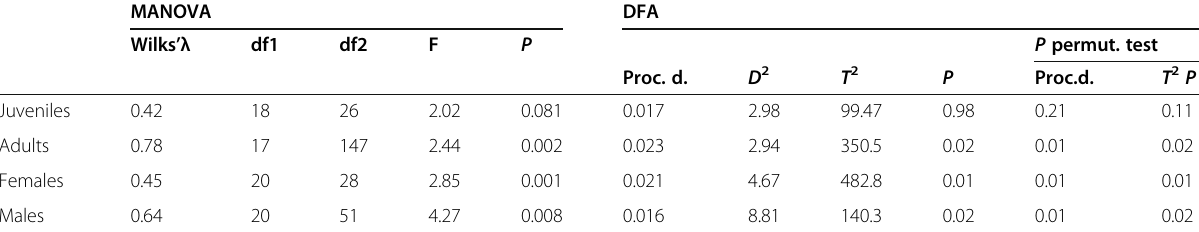
Table 2 The effect of seasons on the body shape of P. pruinosus tested by multivariate analysis (MANOVA) and discrimination functional analysis (DFA) MANOVA DFA Wilks ’ λ df1 df2 F P P permut. test Proc. d. D 2 T 2 P Proc.d. T 2 P Juveniles 0.42 18 0.78 Females 0.45 20